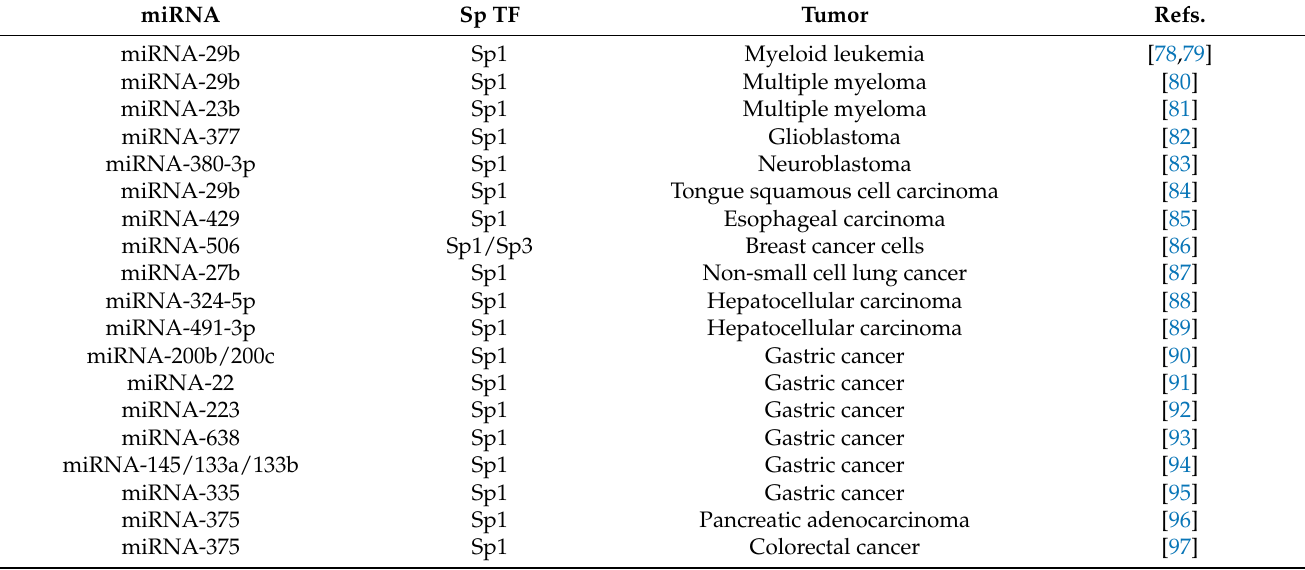
Table 2. MiRNA-Dependent inhibition of Sp.